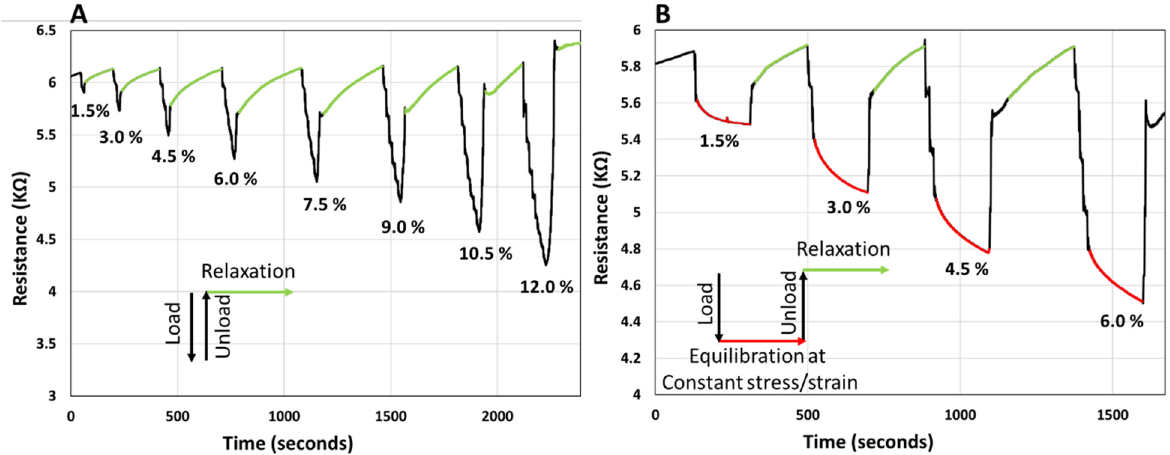
Figure 6. ( A ) Graph showing the electrical resistance of PANi/PVA composite with load (black)-unload (black)-relaxation cycles (green) cycles. The incremental load is expressed by the compressive strain (%). ( B ) Graph showing the electrical resistance of PANi/PVA composite with load (black)-equilibration at constant stress/strain (red)-unload (black)-relaxation (green) cycles. Throughout the equilibration stage (the red curve) the compressive strain is constant. For both graphs, throughout the relaxation stage (the green curve) the applied compressive strain is 0%. The incremental load is expressed by the compressive strain (%). All cycles were applied in the elastic regime of the